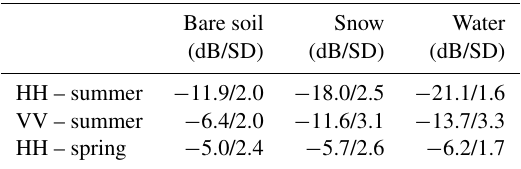
Table 2. Backscattering characteristics of the sampled snow patches, lakes and bare-soil areas. SD is standard deviation. Bare soil Snow Water (dB/SD)